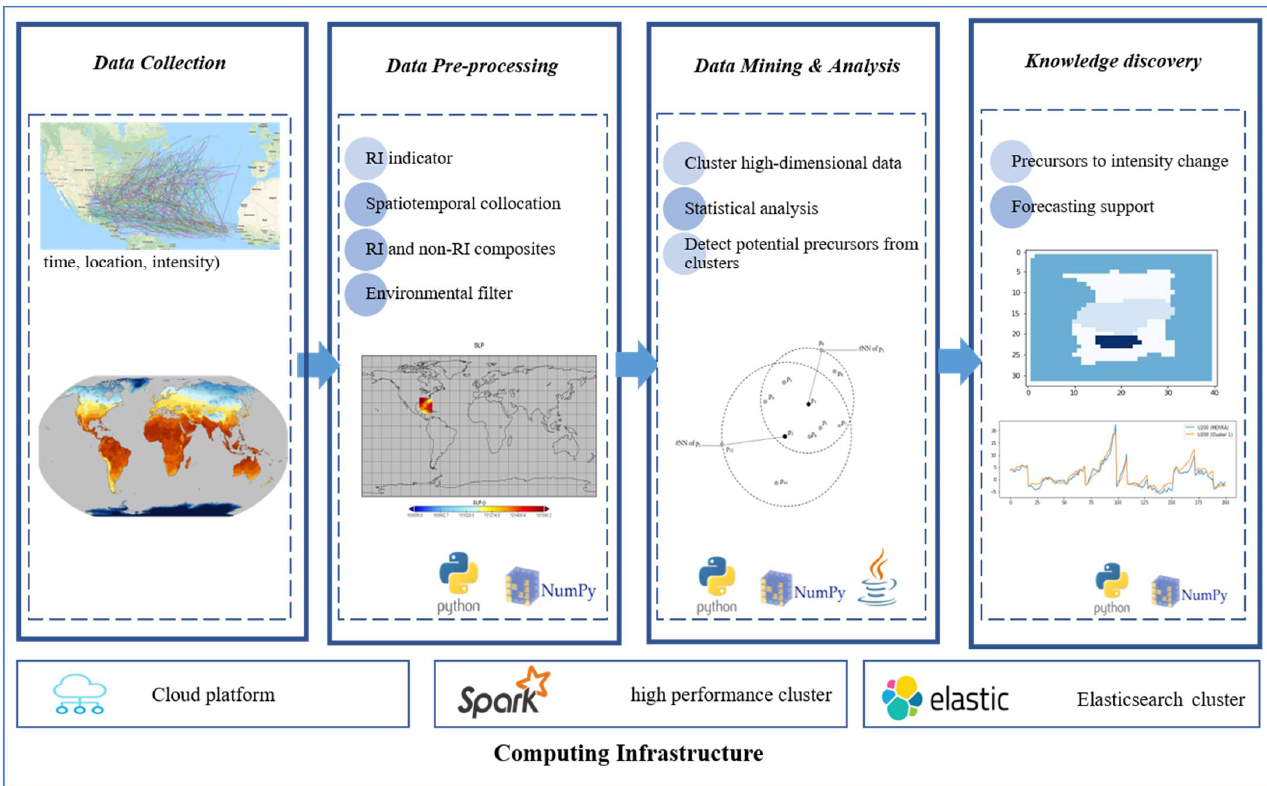
Figure 3. The workflow of discovery of precursors to tropical cyclone rapid intensification.